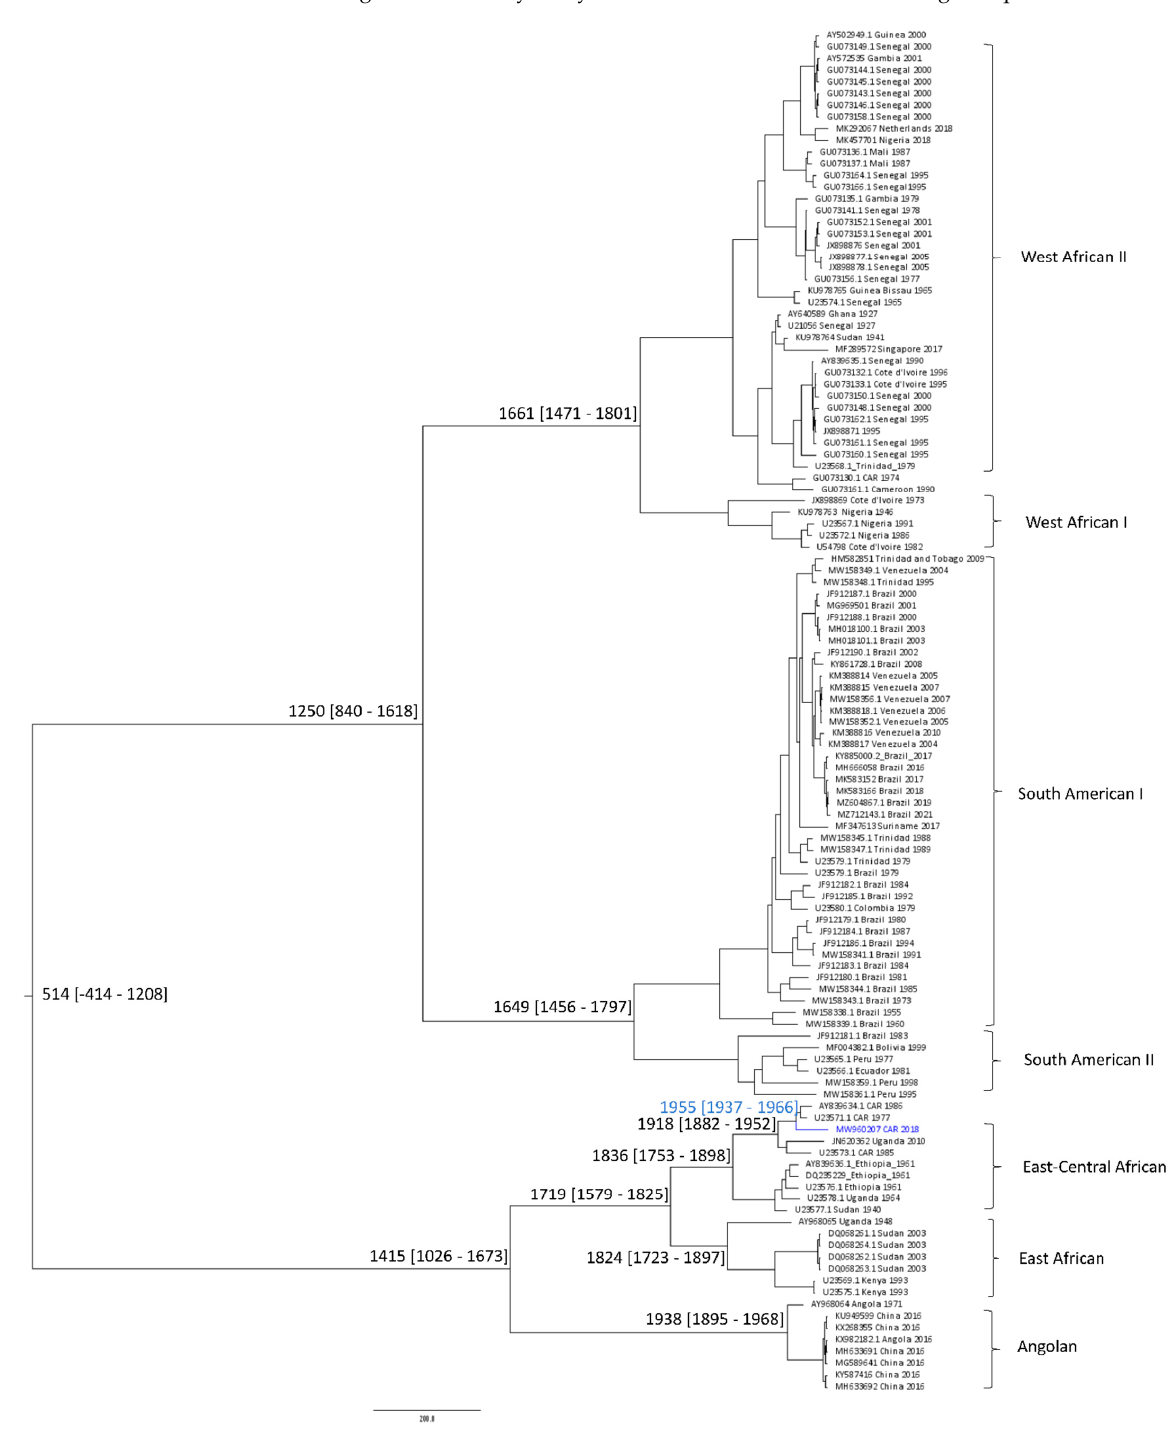
Figure 4. Bayesian chronogram of yellow-fever virus (YFV). The Bayesian analysis was performed on the envelope gene (1455 bp). The YFV genome isolated in the Central African Republic is indicated in blue. Median divergence times are indicated at the major nodes and the 95% highest posterior density (HPD) is given in brackets. TMRCA is show in blue.